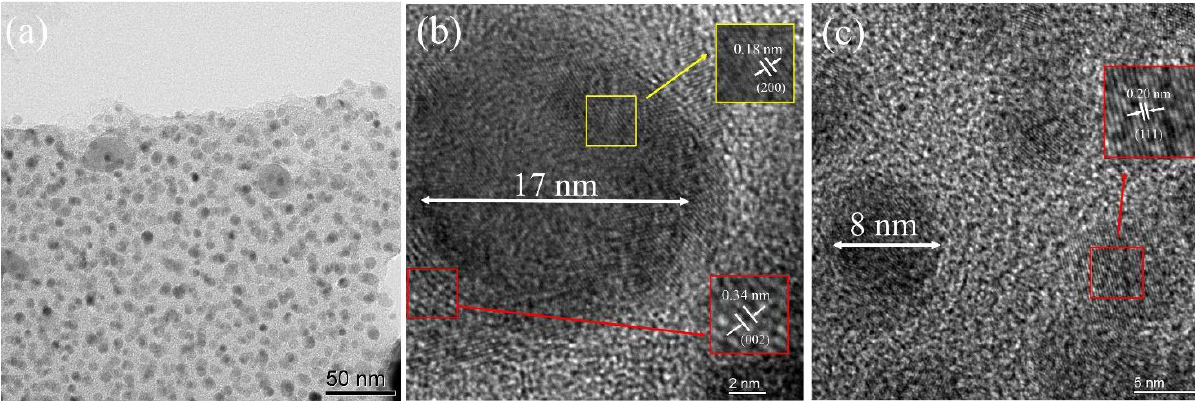
Figure 3. TEM images of NC/Ni-0.25M at different magnifications ( a – c ). Based on the theory of transmission line, the electromagnetic wave absorbing proper- ties of the NC/Ni samples were assessed by the reflection loss (RL) value which was calcu- lated from the relative complex permittivity ( ε r = ε (cid:48) − j ε (cid:48)(cid:48) ) and permeability ( µ r = µ (cid:48) − j µ (cid:48)(cid:48)